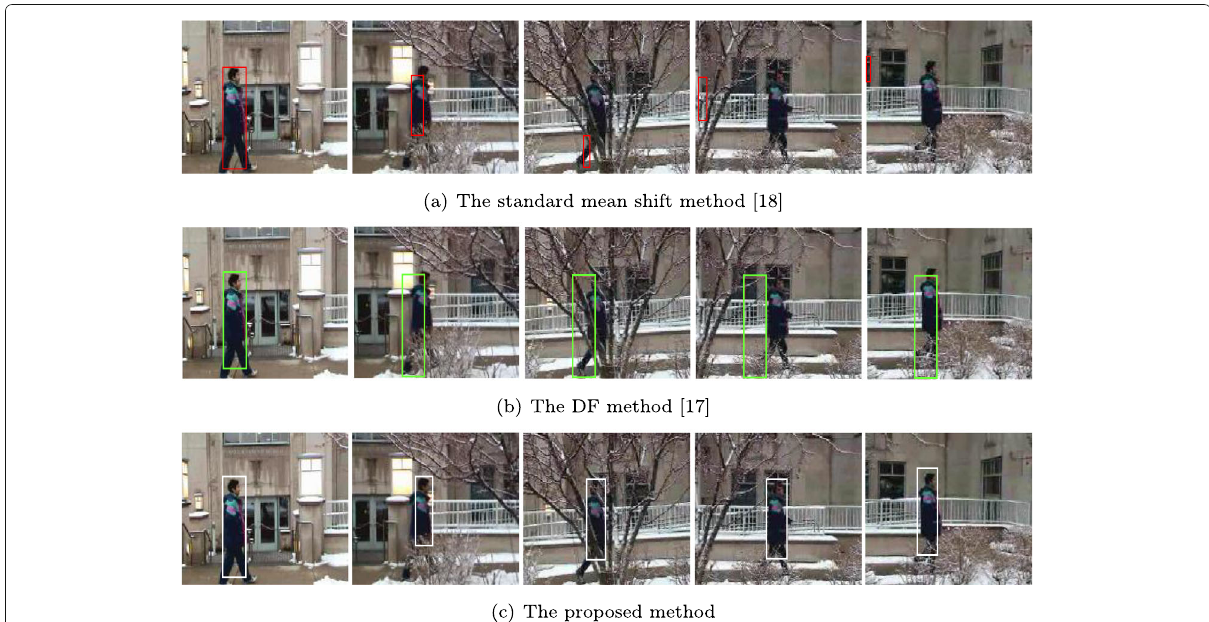
Fig. 3 Tracking results on man video sequence for frames of 2, 85, 145, 197, and 240. a The standard mean shift method [18]. b The DF method [17]. c The proposed method Tracking results of the first test are shown in Fig. 5a, where we can see that the tiger has been successfully tracked despite of its similar color feature to the back- ground plants. Figure 5b shows the tracking results of the second video sequence, demonstrating that our method